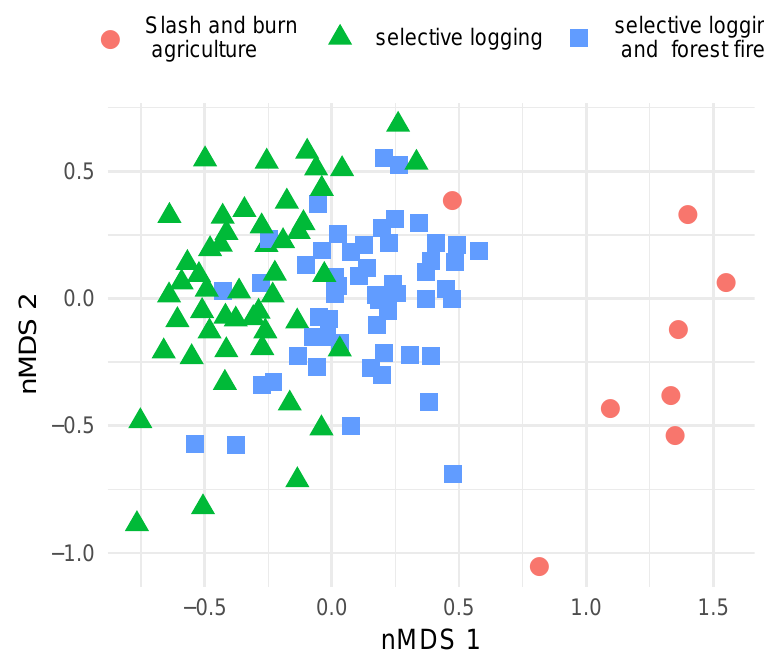
Figure 2. Non-metric Multidimensional Scaling (nMDS) ordination scatter plot, for the study plots by disturbance history. Stress value =